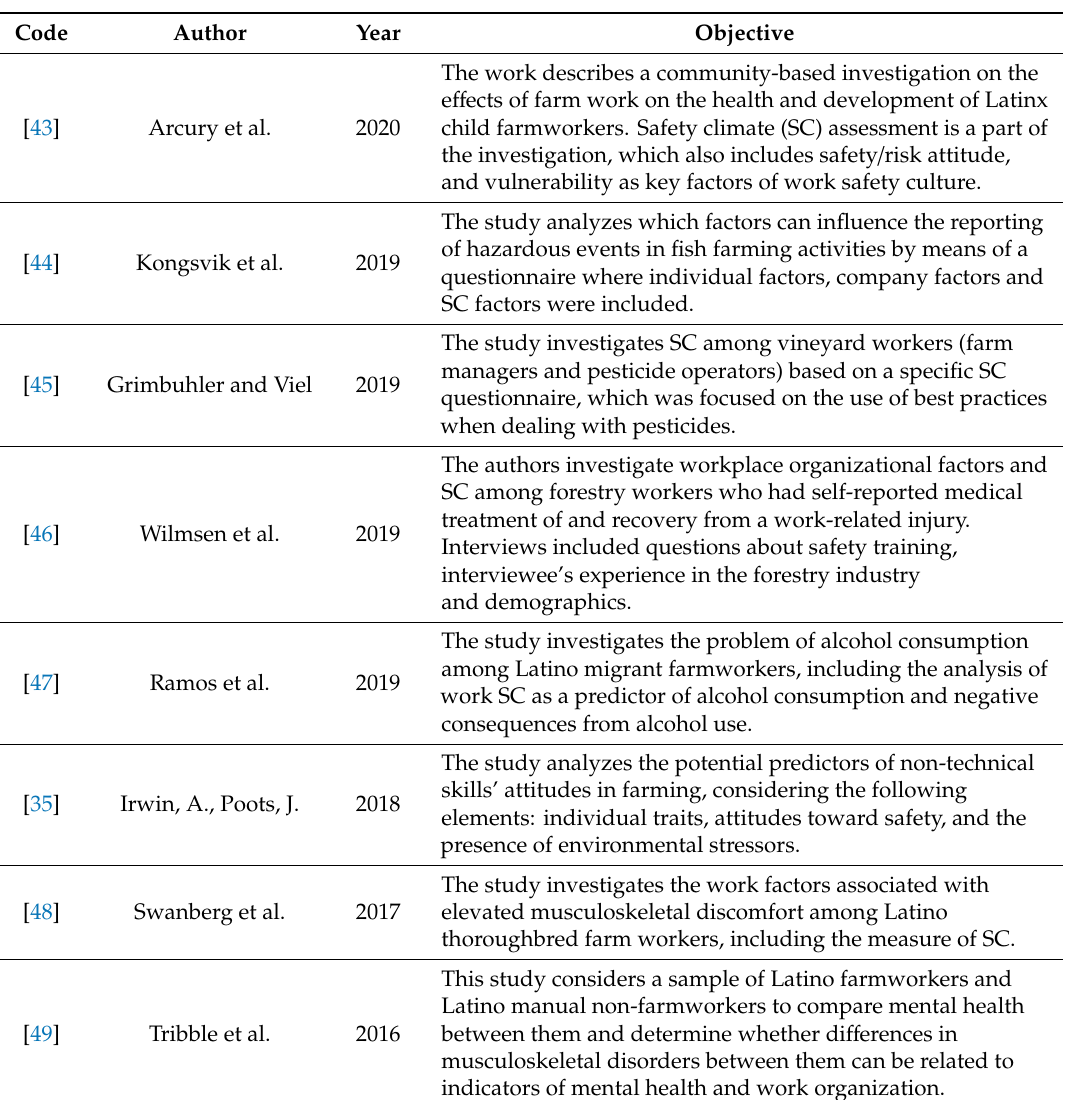
Table 1. Results of the literature review: the contributions are organized per year from 2020 to 2004.